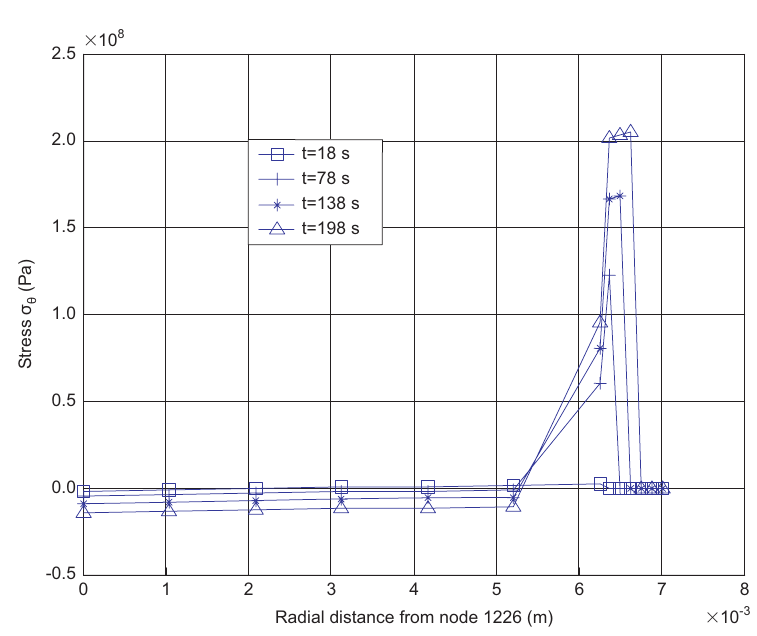
Figure 14 Hoop stresses along radial direction at angle 103.5 ° from node 1226 to node 94 when moving heater is over the spot.